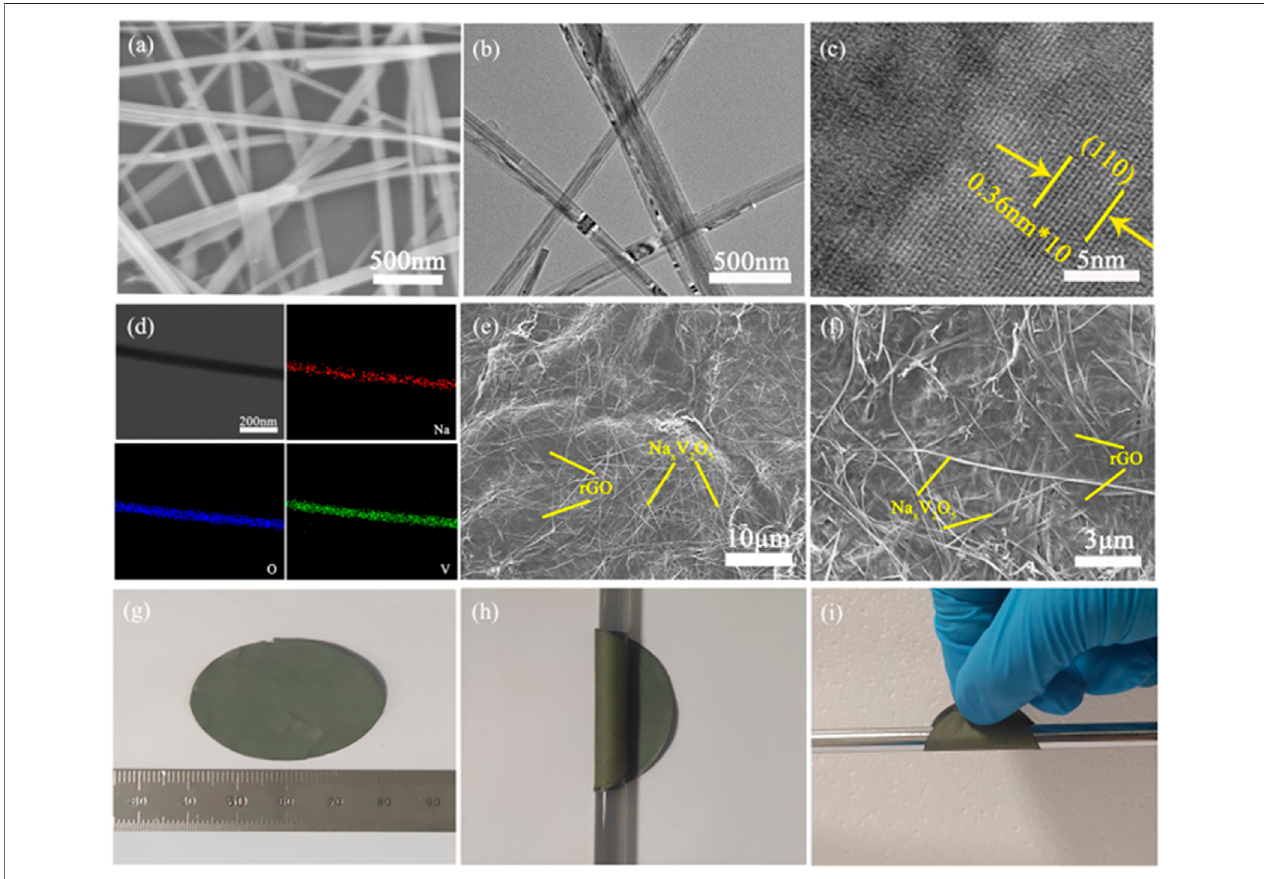
FIGURE 3 | (A) SEM of as-synthesized Na x V 2 O 5 powder; (B) TEM; (C) SAED; (D) EDS spectrum and Na, V, and O concentration in the Na x V 2 O 5 nanobelts. (E,F) SEM images of